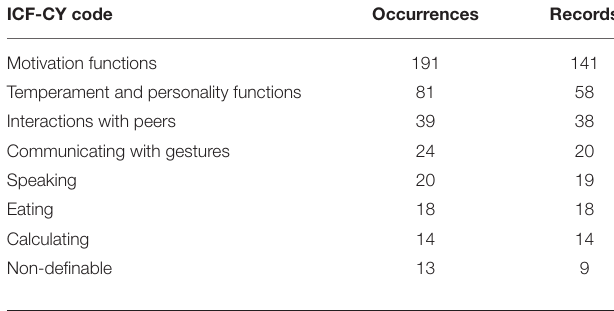
TABLE 2 | Most common ICF-CY codes used to describe abilities/strengths.